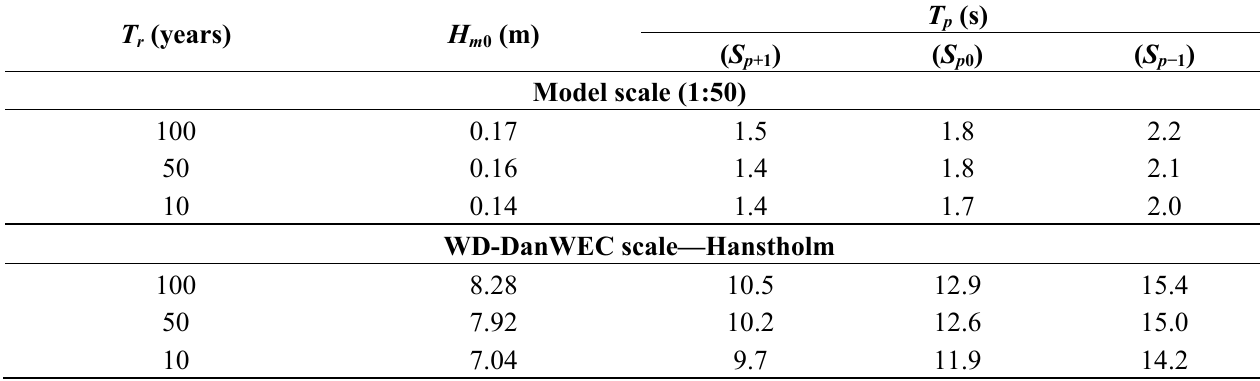
(years) is return period, H r (s) is the peak wave p